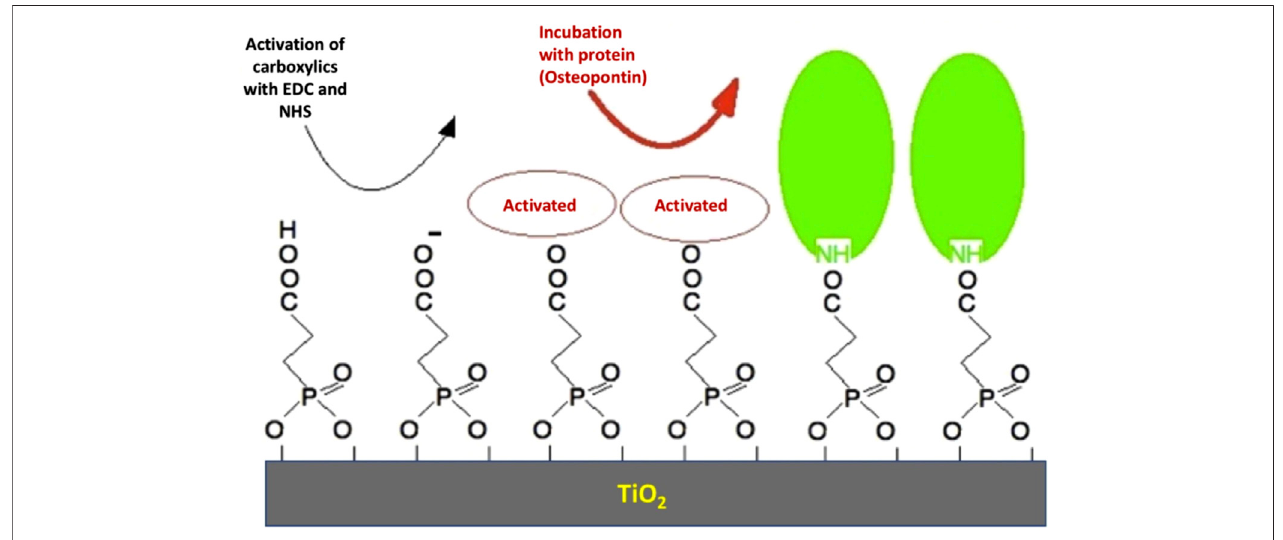
FIGURE 1 | Activation of the carboxyl groups and immobilization of the protein between the carboxyl group and the protein amine. EDC (Ethyl-3-[3- dimethylaminopropyl] carboxyamide). NHS (N-hydroxysulfamide).